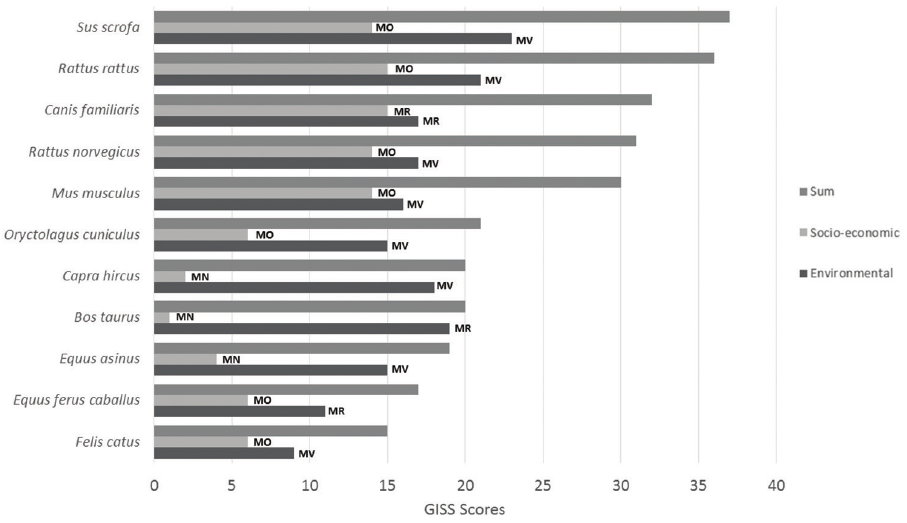
Figure 1. Total GISS environmental and socio-economic impacts of invasive mammal species alien to South Africa. Total scores represent summed scores of maximum impacts given in each subcategory for each species separately. Abbreviations represent impact scores using EICAT (black) and SEICAT (light grey) as minor (MN), moderate (MO), major (MR) and massive